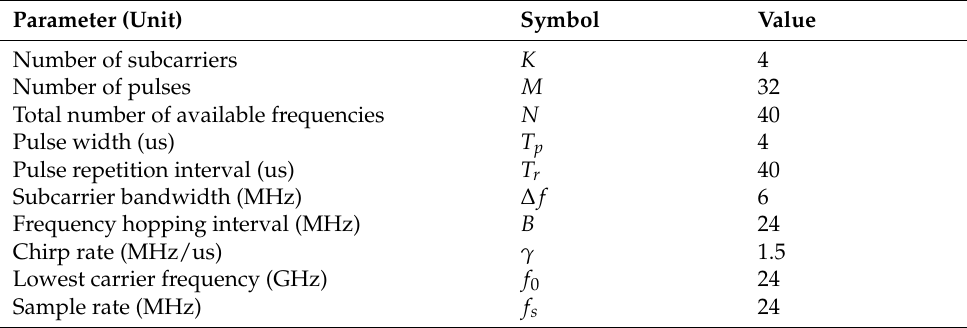
Table 1. Parameters of SFA-OFDM radar.